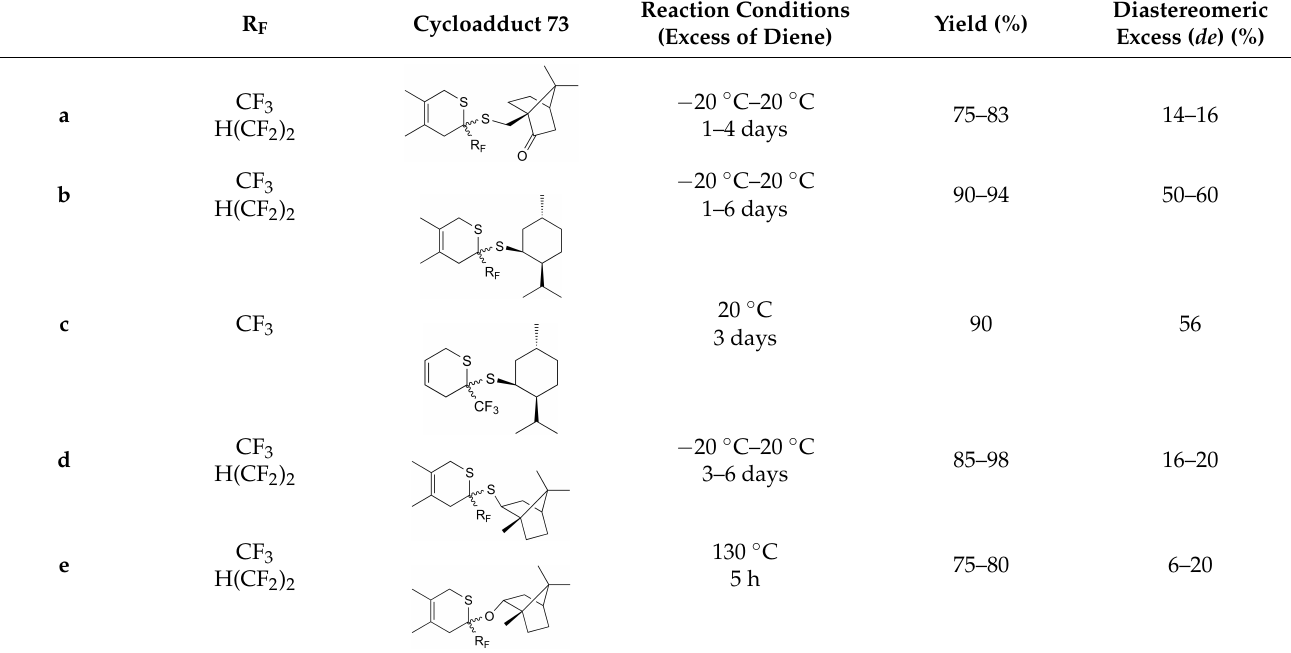
Table 2. Fluoroalkylated 2,4-dihydrothiopyrans 73 prepared via thia-Diels–Alder cycloadditions of perfluoroalkane